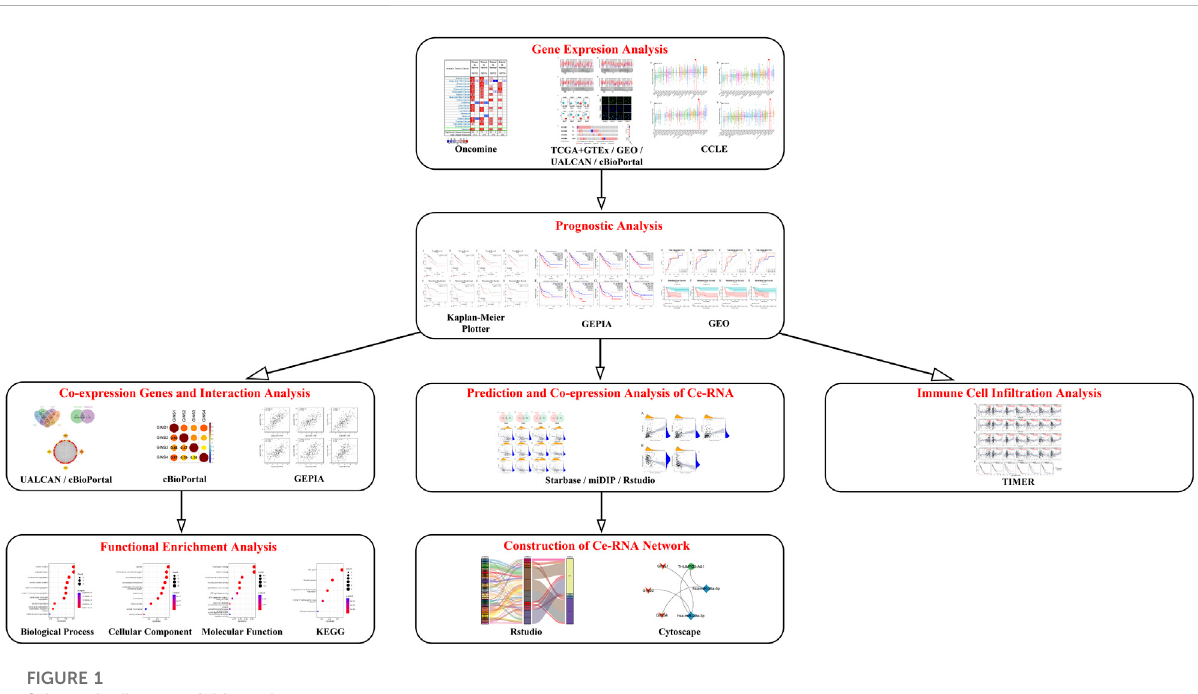
FIGURE 1 Schematic diagram of this